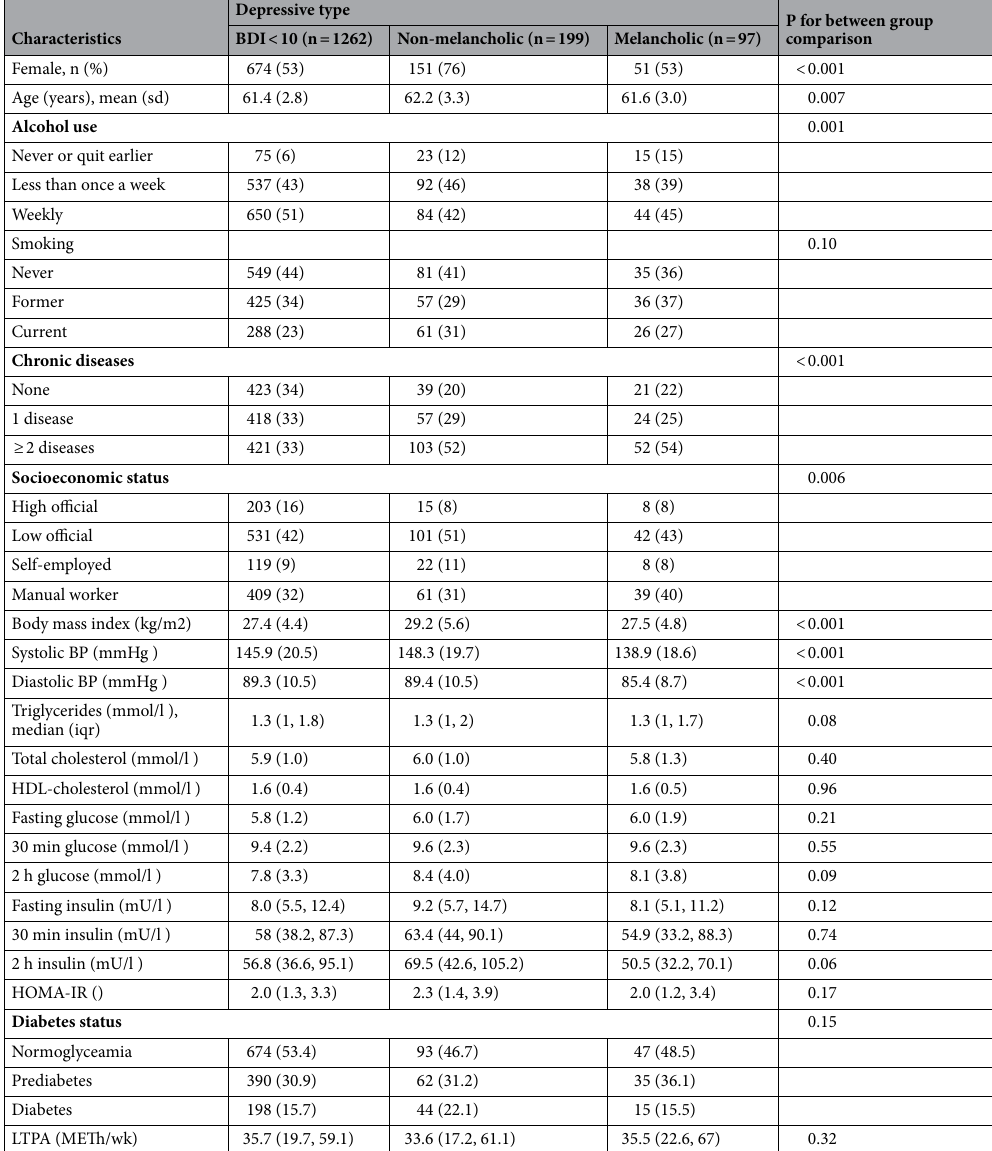
Table 1. Baseline characteristics according to depressive type. BDI Beck Depression Inventory, BP blood pressure, HDL high-density lipoprotein, HOMA homeostasis model assessment for insulin resistance, LPTA leisure time physical activity, MET metabolic equivalent of task (1 MET = 3.5 ml of O 2 /kg/min). P values of the continuous variables were based on the bootstrap style method of 10,000 repetitions in all variables except for systolic BP, diastolic BP, and